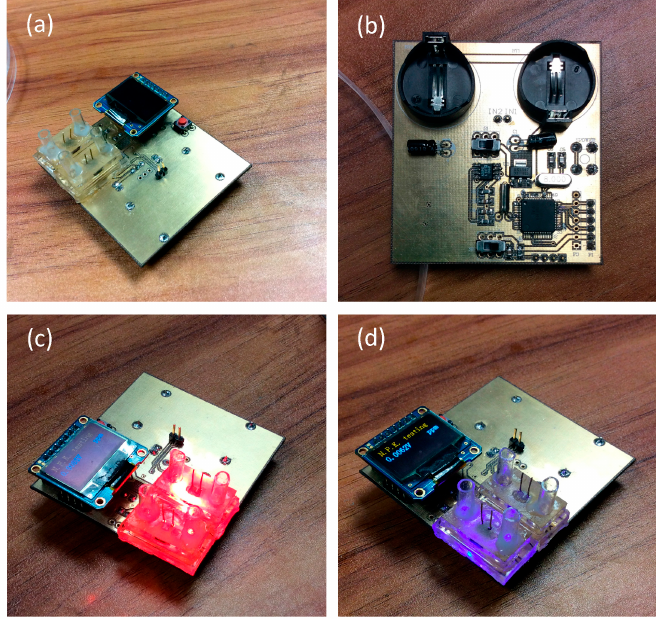
Figure 6. The colorimeter circuit: ( a ) top view, ( b ) bottom view, ( c ) red light working mode, and ( d ) blue light working mode.